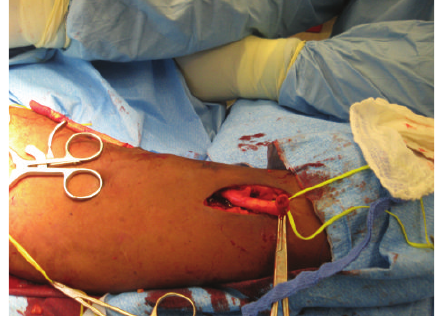
Figure 5: The anastomosis has been excised completely and the remnant defect repaired. The graft is being excised from the upper